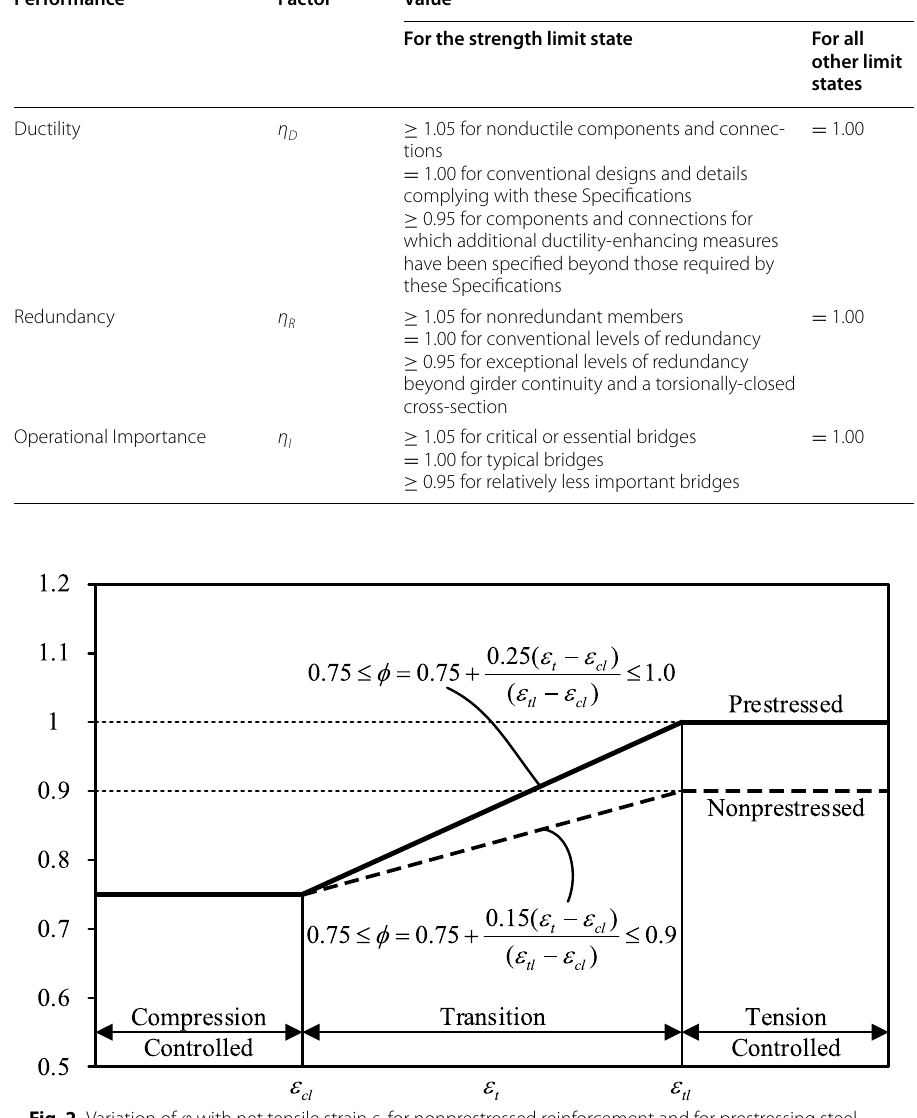
Table 2 The specific values of η Performance Factor Value